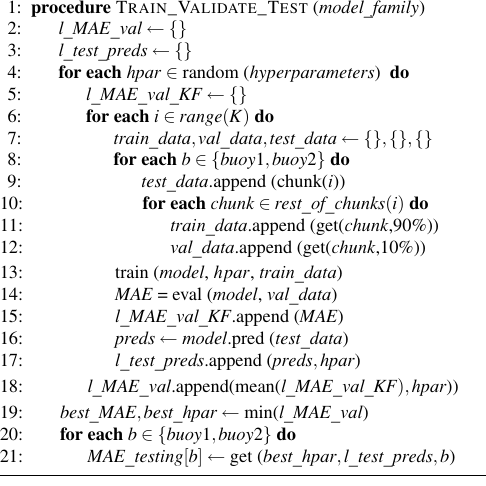
◦ C), EC ( µ S/cm), pH (und), system battery (V) and Chl- a ( µ